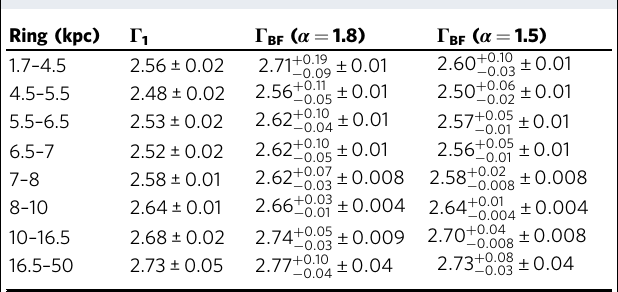
Fig. 2 Pulsar wind nebulae cumulative spectrum. The cumulative spectral energy distribution of the Pulsar Wind Nebulae observed both by Fermi- LAT and H.E.S.S. (black thick line). We show with a red line a broken power-law spectrum with an energy break E 0 = 0.8 TeV and spectral indexes β TeV = 2.4 and β GeV = 1.89. The shaded bands are obtained by propagating statistical and systematic uncertainties in the source spectra given in 4FGL-DR2 36 (orange band) and HGPS 22 (blue band) catalogs. The dashed black line represents the average theoretical spectrum obtained by integrating over the spectral parameter space (see Sect. Robustness of our results and comparison with previous studies). It corresponds to the central values of Γ BF given in Table 2 and it is normalized in order to produce the same number of photons in the TeV energy domain as the observed cumulative Pulsar Wind Nebulae spectrum. Table 2 Gamma ray spectral indexes.